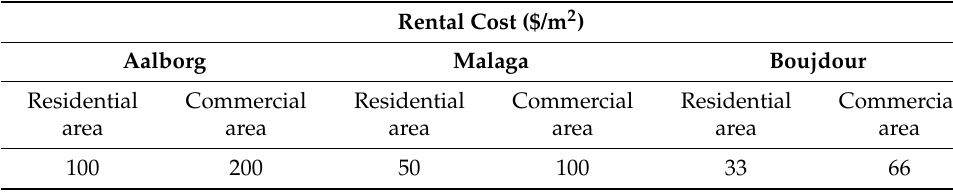
Table 2. Rental cost for base station sites.